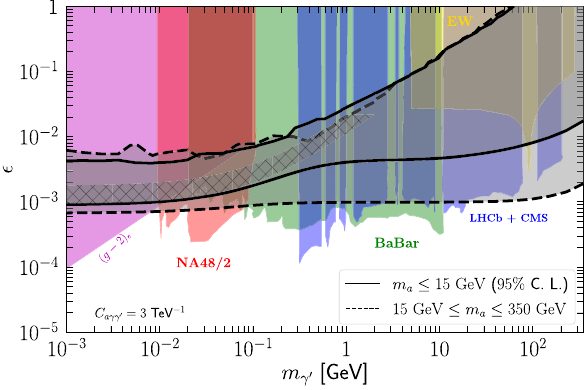
Fig. 3 Experimental constraints on the ALP Yukawa coupling with muon from (1) supernova cooling from SN1987a (purple region) [69]; (2) kaon decay K → μν a [66] (red region) at NA62; (3) final-state radiation e + e − → μ + μ − a (green region) at the BaBar experiment [66,70]; (4) rare Z decay (blue region) at CMS [71]. The projected sen- sitivities at NA64 (brown dashed line) [67], Belle II (green dashed line), and HL-LHC (blue dashed line) [68] are also shown for comparison. The black contours are the allowed region for explaining the observed